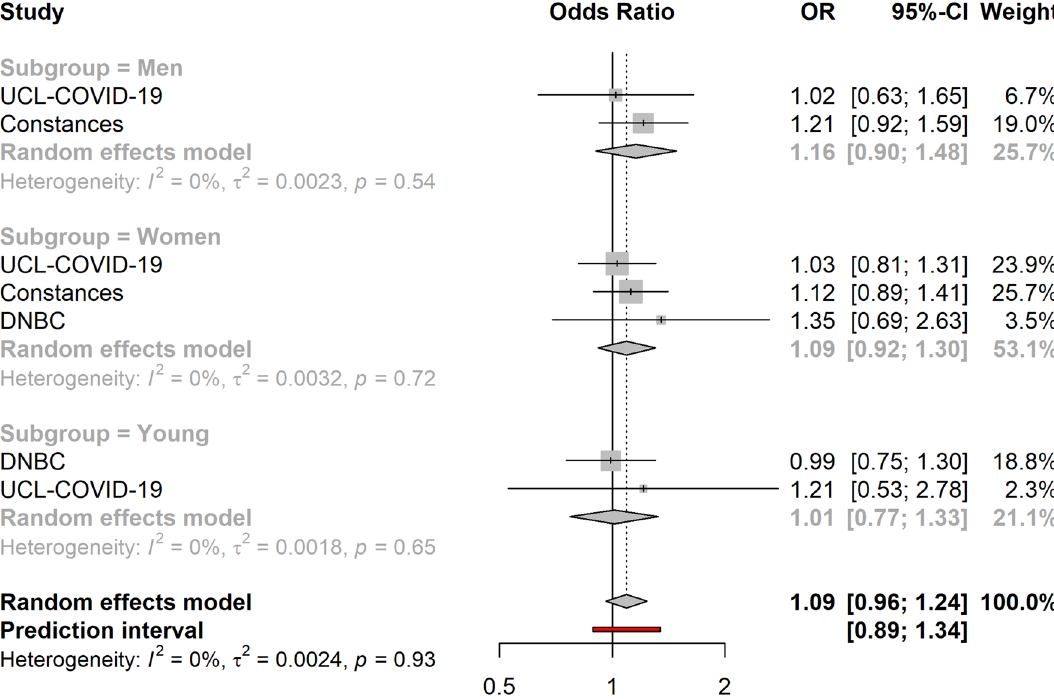
Figure 2. Association between access to outdoor space (yes vs. no) and high levels of anxiety (N = 68,712). The cohort-specific estimates and 95% confidence intervals were obtained using binary logistic regression models. Age, educational attainment, gender, previously diagnosed chronic disease status and presence of previously diagnosed mental illness were used a covariates. In addition, the models included mutual adjustment for the other housing exposures. 95% CI 95% confidence interval, OR odds